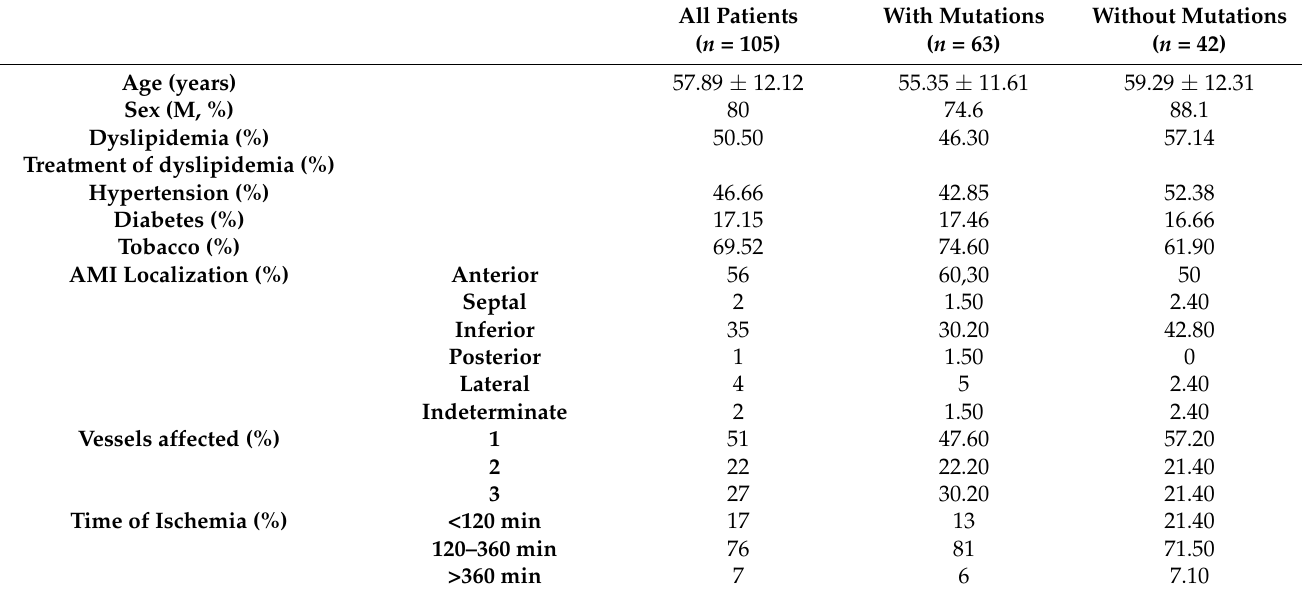
Table 1. Clinical data and demographic characteristics of the studied population. All